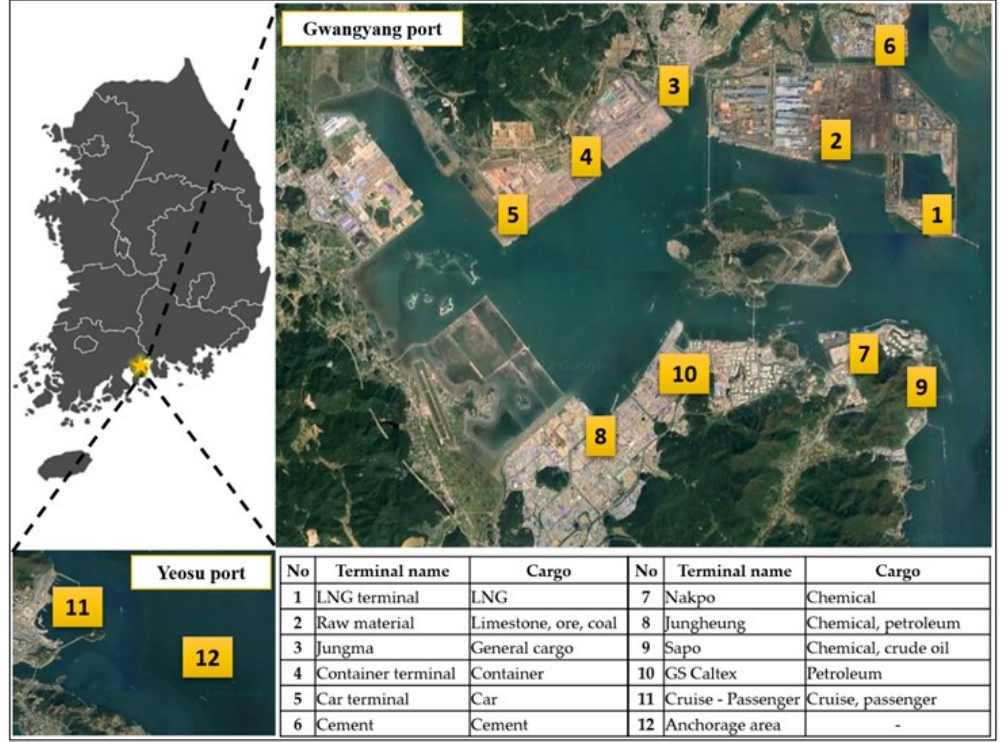
Figure 1. Major terminals at Yeosu and Gwangyang ports. Note: Images were adopted from Google map and were then modified.